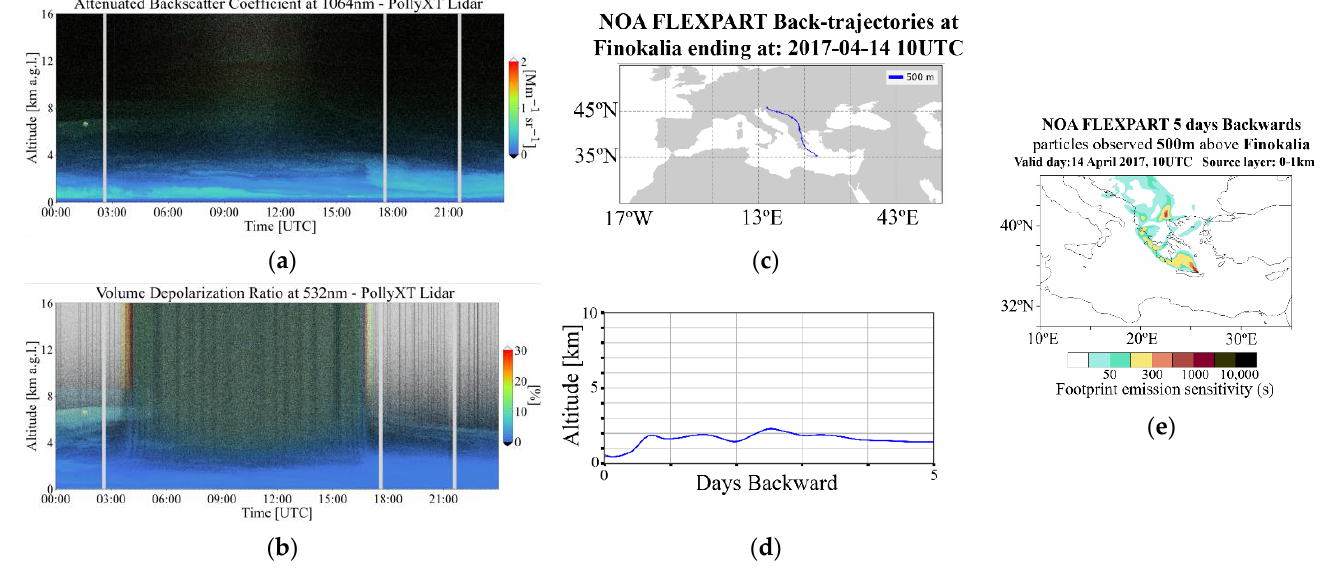
Figure 10. ( a , b ) PollyXT Lidar parameters for 14 April 2017 00:00 – 24:00 UTC: Attenuated Backscatter Coefficient at 1064 nm channel in arbitrary units (a.u.); Volume Depolarization Ratio in percentage units, ( c , d ) Air mass backward trajectories, based on FLEXPART simulations, ending at 500 m above the Finokalia station on 14 April 2017 at 10:00 UTC; Altitudes, above ground level, of the air masses on their route prior their arrival over the ground station, ( e ) FLEXPART Source Receptor Relationships (s) for air masses originating from 0 – 1 km a.s.l. arriving above Finokalia at 500 m on 14 April 2017, 10:00 UTC.